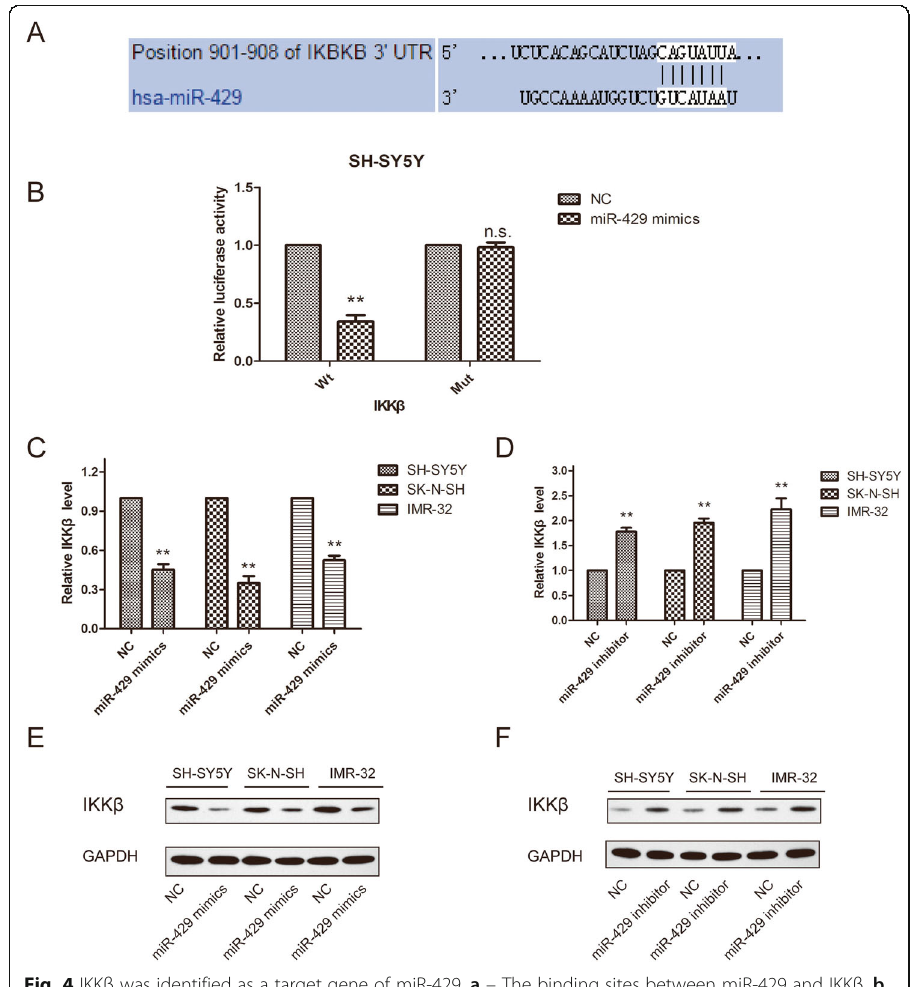
expression increased the expression of IKK β at the mRNA level in SH-SY5Y, SK-N-SH and IMR-32 cells. d – Overexpression of miR-429 inhibited the expression of IKK β at the mRNA level in SH-SY5Y, SK-N-SH and IMR-32 cells. e – Western blot showing IKK β protein expression levels in SH-SY5Y, SK-N-SH and IMR-32 cells after transfection with NC-mimic, miR-429 mimics. f – Western blot showing IKK β protein expression levels in SH-SY5Y, SK-N-SH and IMR-32 cells after transfection with NC-inhibitor and miR-429 inhibitor. GAPDH was used as the endogenous control. Error bars represent the means ± SEM of at least three independent experiments. N.S.: not significant; * p < 0.05 and ** p < 0.01 vs. the control